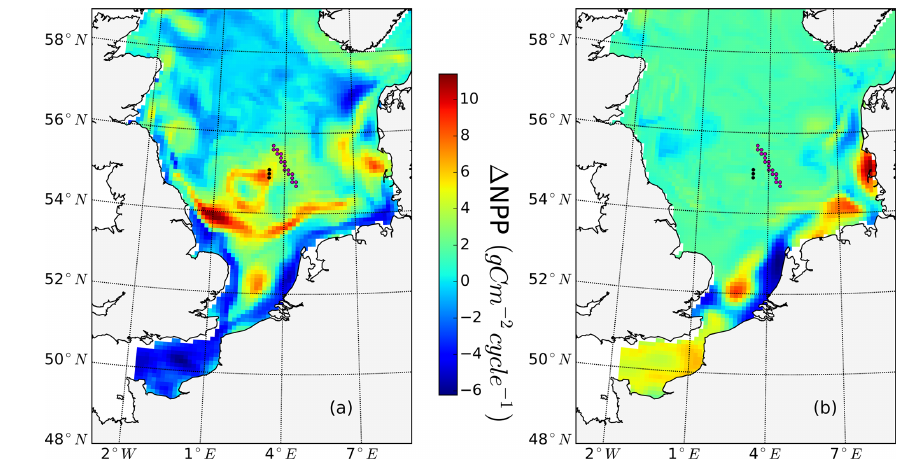
Figure A5. Vertically integrated NPP contributed by tide (M 2 + S 2 ) (a) and spring–neap tide (b) for one spring–neap cycle (26 July– 8 August 1997) during the observational period studied by Richardson et al. (2000). Magenta dots depict the location of the transect which Richardson et al. (2000) has analyzed. Black dots depict the exact location of fronts in our simulation.